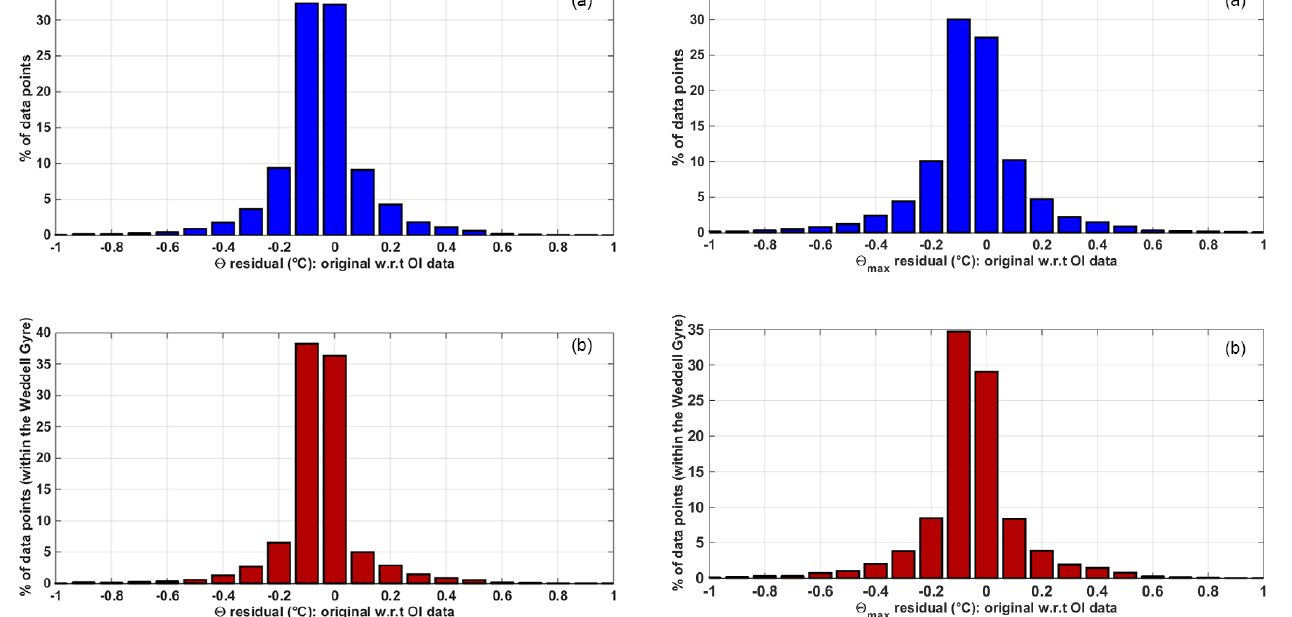
Figure 18. The percentage of data points binned by temperature residuals ( ◦ C) at the sub-surface temperature maximum, where the float data objectively mapped to the profile locations are subtracted from the original profile data points, for (a) the entire data set and (b) for those data points within the defined Weddell Gyre region